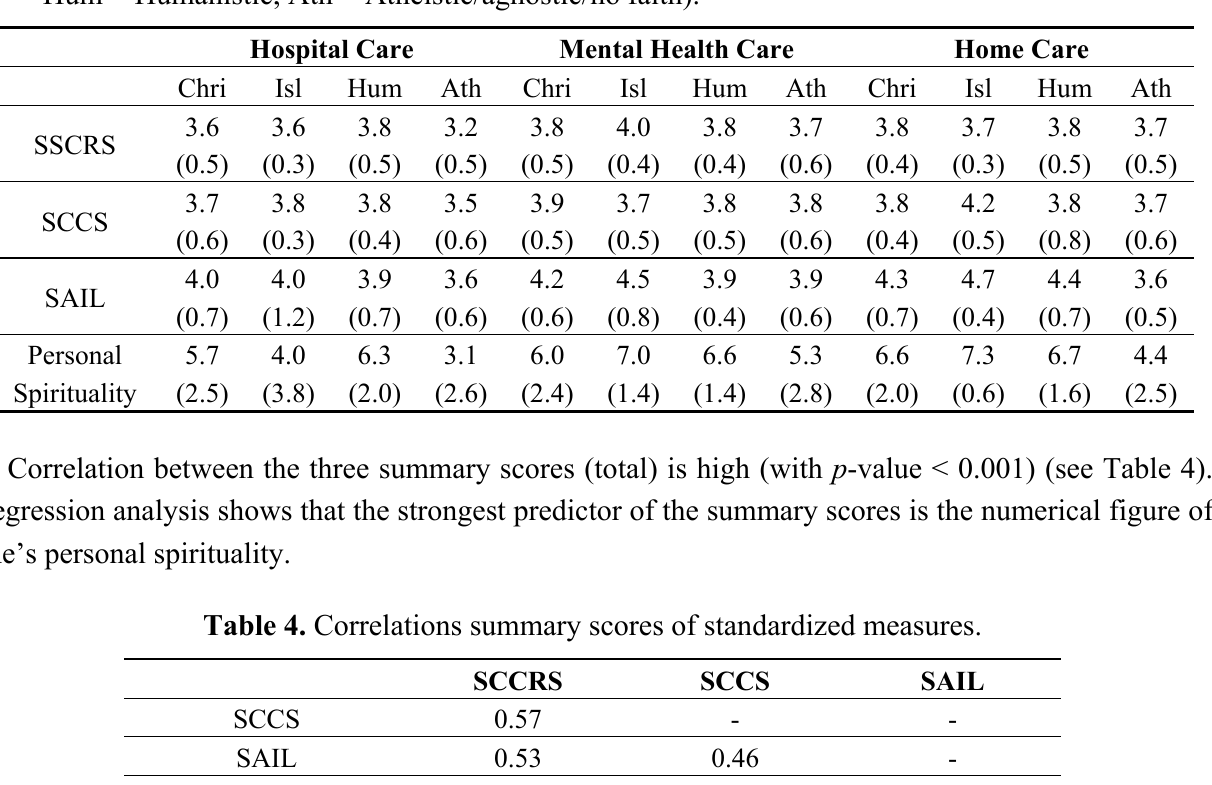
Table 3. Summary scores of standardized measures (with SD): SSCRS, SCCS and SAIL per life view and health care setting (Chri = Christian, Isl = Islam/Hinduism/Buddhism, Hum = Humanistic, Ath = Atheistic/agnostic/no faith).